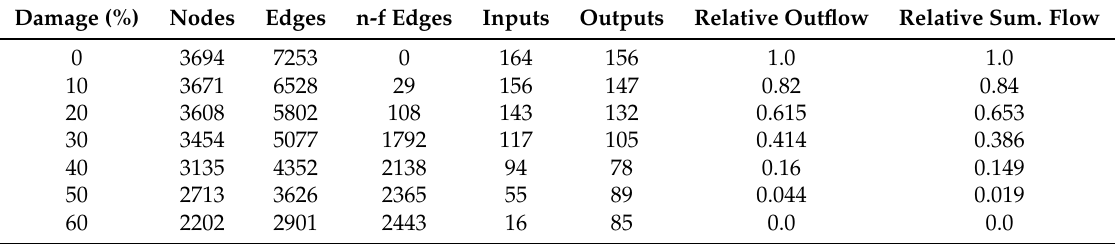
Table 3. System degradation for constant boundary